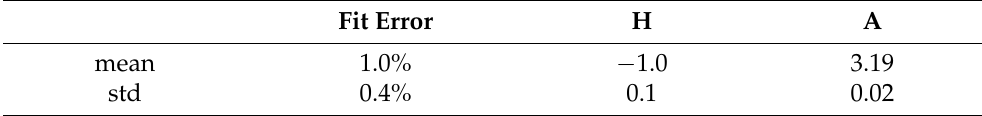
Table 1. First hypothesis statistics.